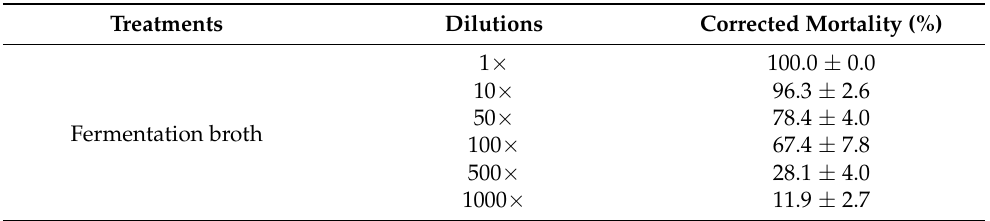
Table 5. Acaricidal activity of fermentation broth and supernatants of Bacillus vallismortis NBIF-001 against Tetranychus urticae